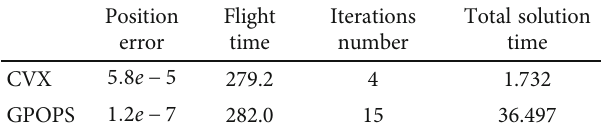
Table 6: Comparison of results between two